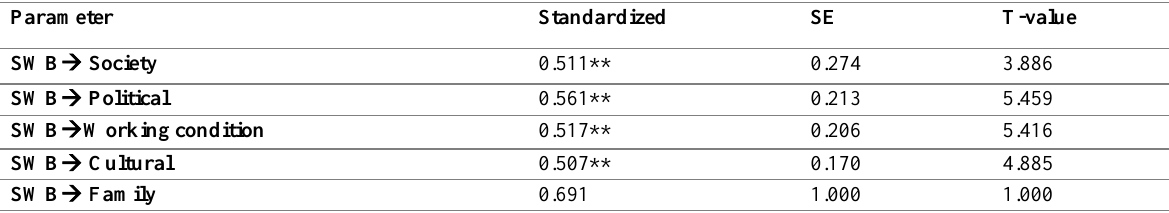
Table 4: Second Order Factor and Its First Order Factor’s Loadings